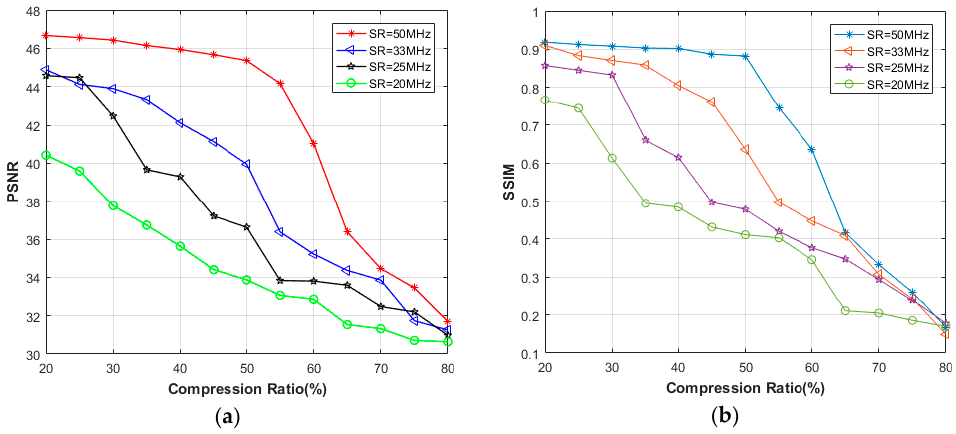
Figure 13. Comparative ( a ) PSNR, ( b ) SSIM between different SRs in time domain, using experimental through-holes data.